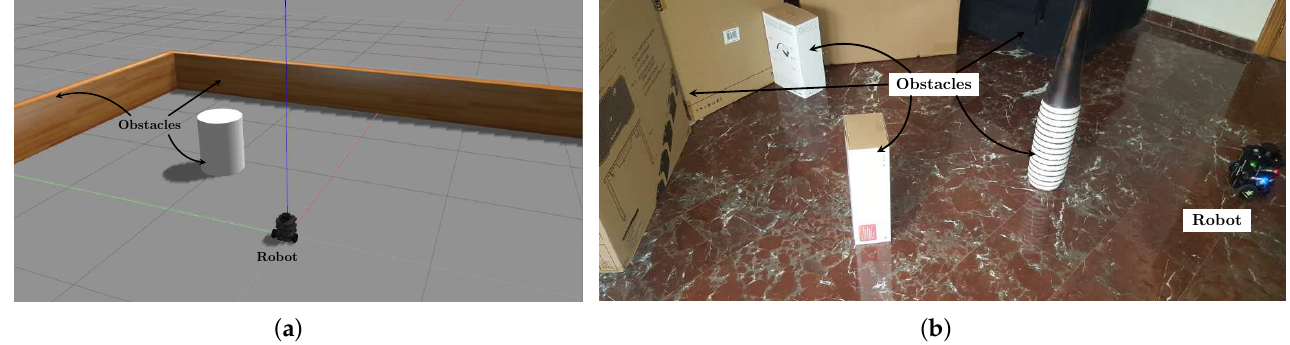
Figure 3. Experimental setup: remote environment. ( a ) Simulation setup. ( b ) Real setup. The parameter values used for the high level controller of the robot are as follows: po- tential field-based method { ρ 0 = 0.35, K att = 0.75, K rep = 1 } ; robot kinematics { L = 0.16 m, M = 0.052 m, r = 0.033 m } ; and boundary circle with radius R = 0.18 m and center located at the mobile robot tracking